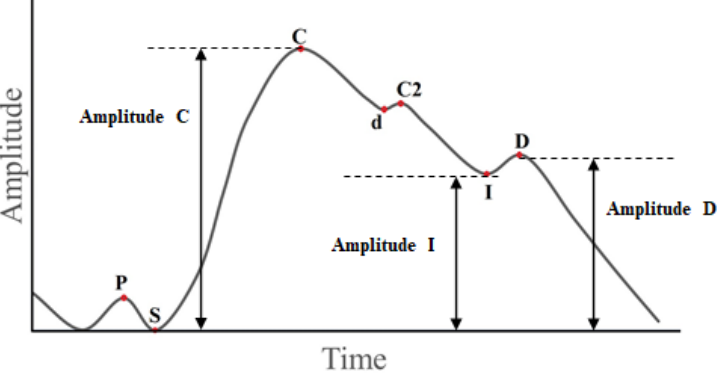
Figure 1. The ideal bioimpedance signal in the extremities, P is the presystolic wave peak, S is the beginning of systolic wave, C is the first systolic wave peak, C2 is the second systolic wave peak, d is the dicrotic wave peak, I is the incisura, and D is the diastolic wave